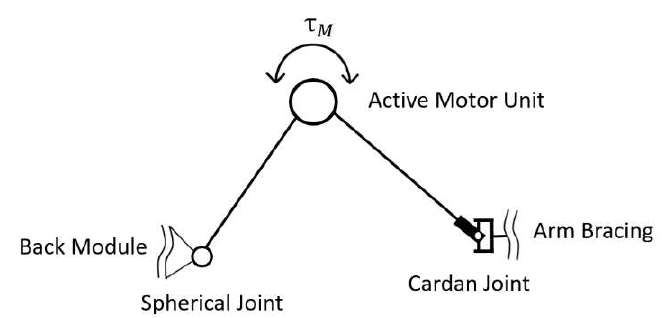
Figure 11. Mechanical exoskeleton concept to generate push and pull support.